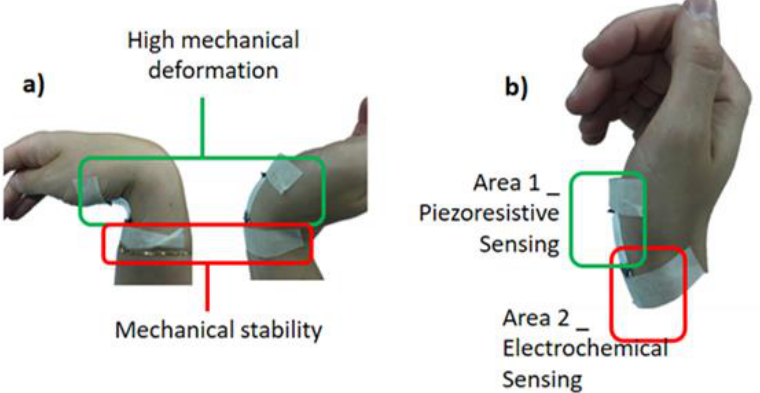
Figure 1. Application scheme of the NFs pH-Flex Sensors device, with highlight of ( a ) the two me- chanical deformation zones and ( b ) the disposition of the sensors on the device based on these zones.